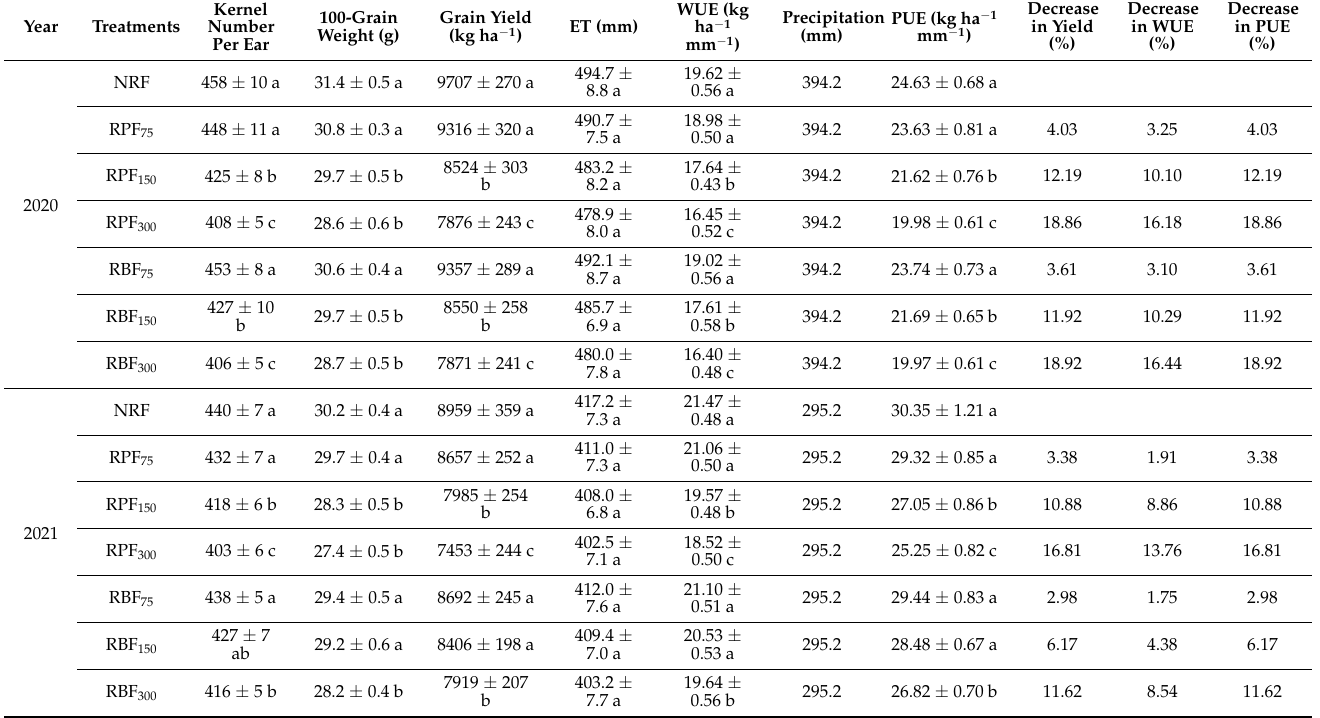
Table 1. Differences of yield components, grain yield, evapotranspiration (ET), water use efficiency (WUE), precipitation, and precipitation use efficiency (PUE) under different treatments in 2020 and